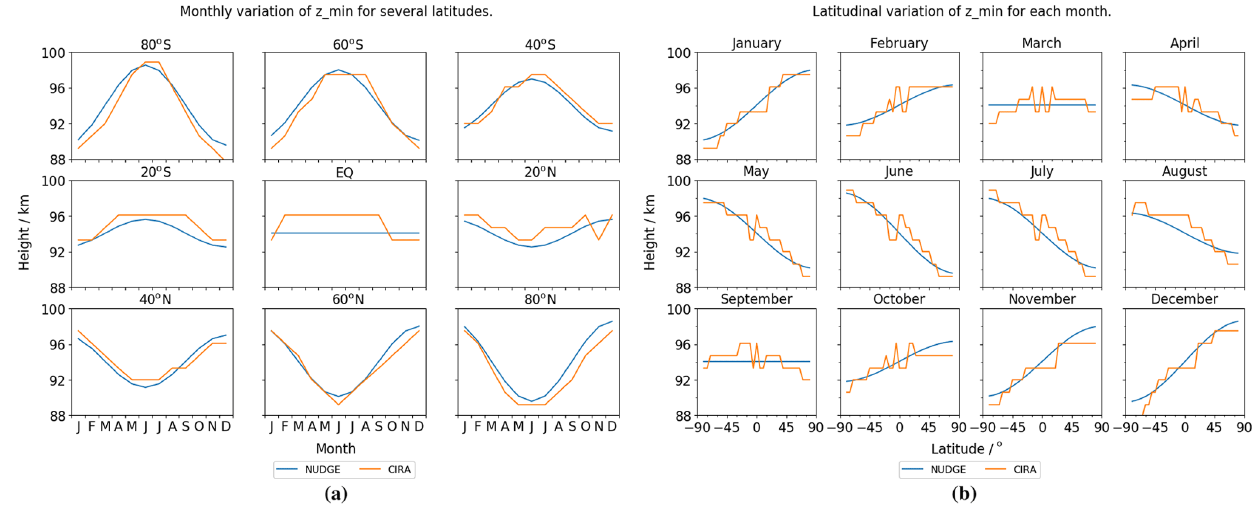
Figure 2. Variation in the fitted mesopause height profile z min for (a) several latitudes as a function of month and (b) all months as a function of latitude. The fitted function gives a reasonable fit for the purposes of the nudging